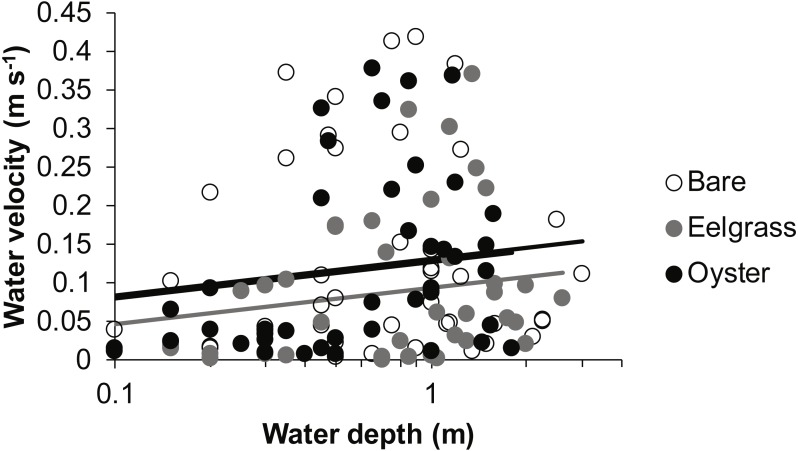
Water velocity during drifts when water was at different depths over three intertidal habitat types at five sites in Washington State, USA.Lines are plotted from the coefficients of a linear mixed effects model including factors significant at α < 0.05. Although the residuals in this plot appear to violate assumptions of normal distributions, the distributions were suitable for analysis in the linear mixed effects model, which accounted for site and subsite as random effects.